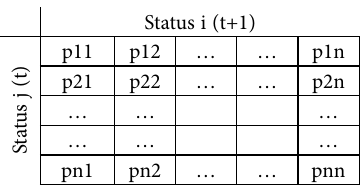
Table 4. Stochastic